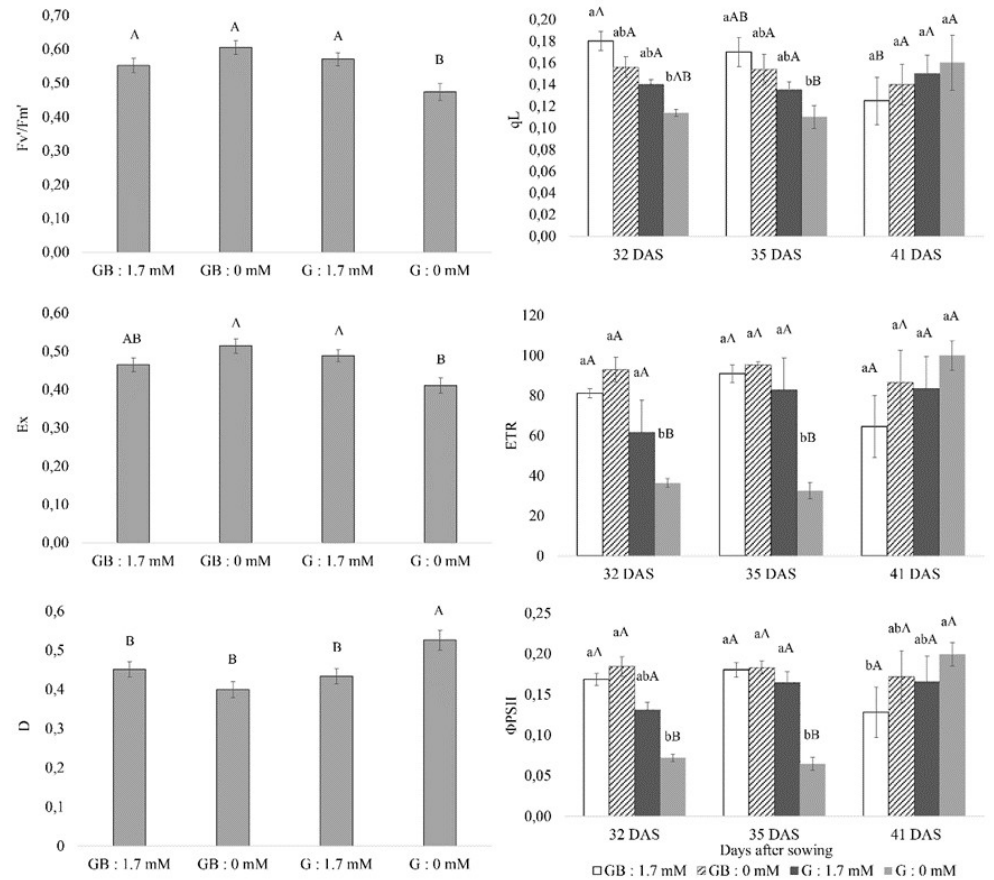
Figure 1. Chlorophyll a fluorescence, photosystem II efficiency (Fv’/ Fm’), light fraction absorbed by the PSII antenna dissipated as heat ( D ), excitation energy fraction not dissipated in the antenna that cannot be used for the photochemical phase ( Ex ), photochemical quenching (qL), electron transport rate (ETR), effective quantum yield ( φ PSII) of Glycine–Bradyrhizobium and Glycine cultivated with 0 mM and 1.7 mM nitrate. Uppercase letters indicate significant differences between seasons, and lowercase letters indicate significant differences between treatments ( p < 0.05). G, Glycine ;